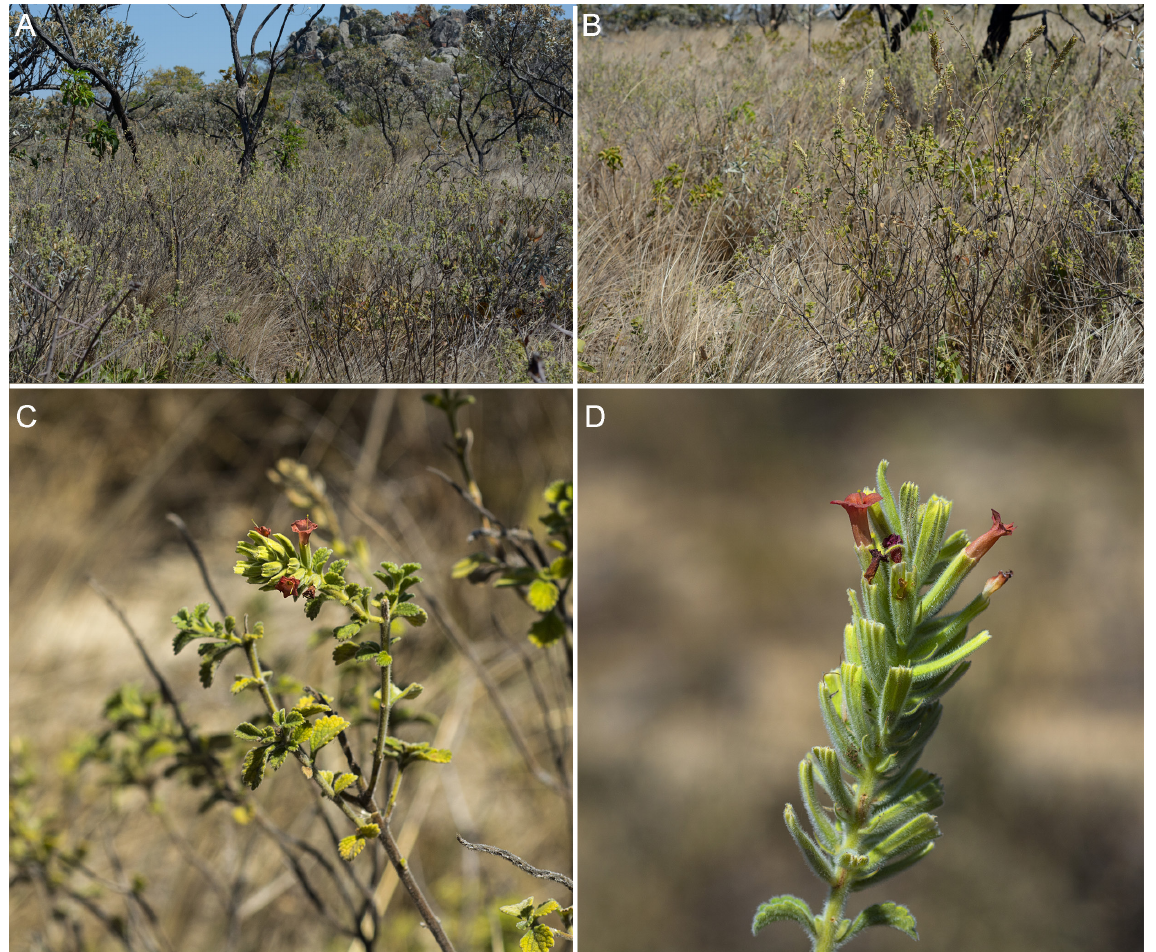
Fig. 12. Stachytarpheta minasensis (S.Atkins) P.H.Cardoso comb. and stat. nov. A . Habitat. B . Habit. C–D . Individuals showing details of the leaves and inflorescences, highlighting the short pedicels, bracts, calyxes, and corollas. Photos by Pedro Henrique